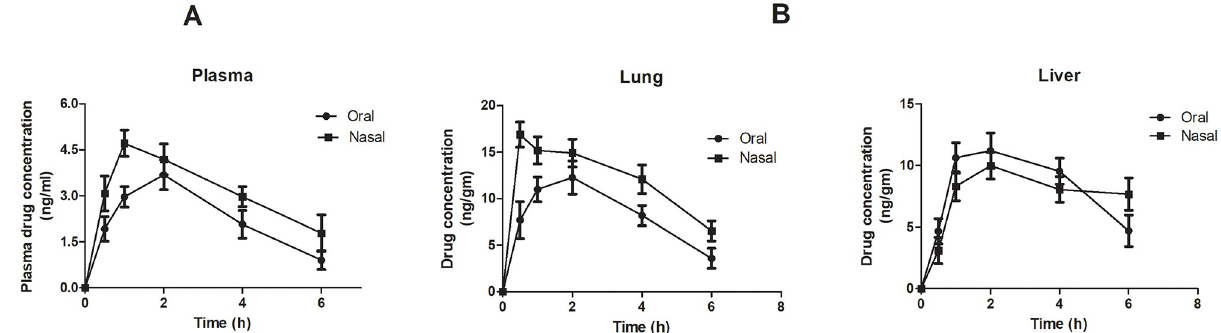
Fig 1. (A) Plasma concentration-time profile of bromelain and (B) Tissue distribution profile of bromelain in lungs and liver after oral (40 mg/Kg) and nasal (10 mg/Kg) administration of bromelain solution respectively.